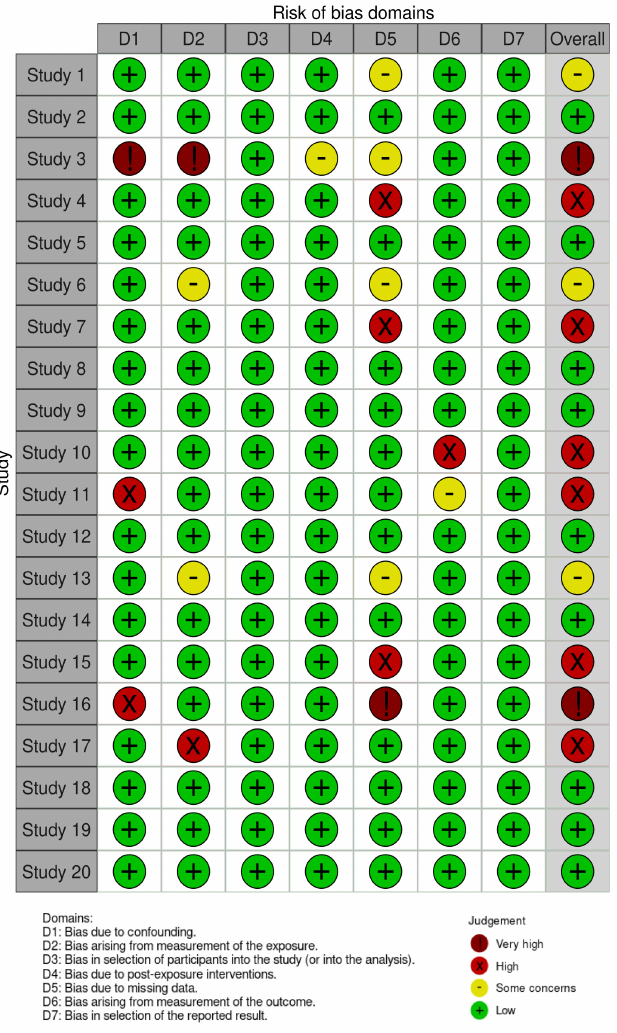
Figure 2. Assessment of the risk of bias of each study considering the ROBINS-E domains. Characteristics of study participants in the included studies are depicted in Supple- mentary Table S2. Two studies (10.0%) [67,68] were focused on children (boys and girls) and 18 on adults [one in men (5.0%), eight in women (40%; six of them during pregnancy) and nine (45.0%) included men and women]. The majority of studies included healthy population exclusively ( n = 13, 65.0%), five studies combined healthy and pathologic pa- tients (people with diabetes, allergic rhinitis, rheumatoid arthritis, and polycystic ovary syndrome), one study was focused on patients with Crohn’s disease and another study on women with unexplained recurrent spontaneous